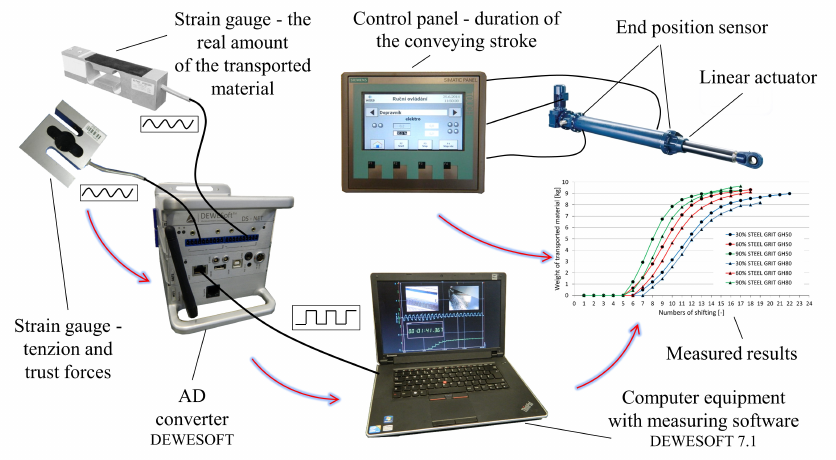
Figure 5. Scheme of the measuring chain with the measuring system, DEWESOFT